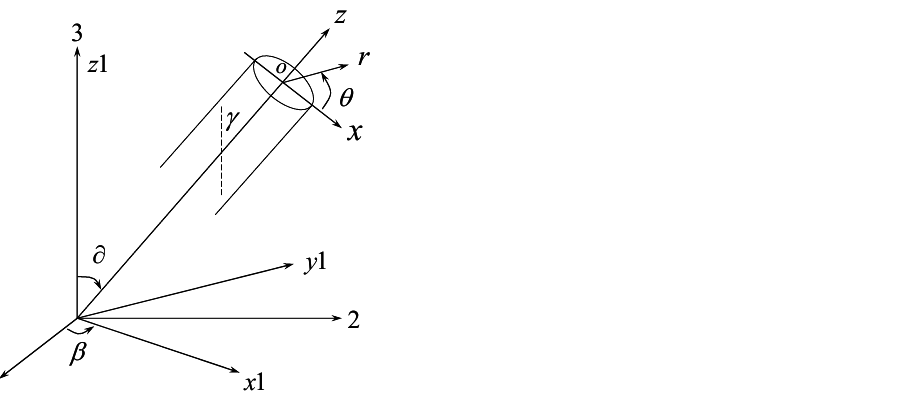
Figure 4. Coordinate system used to transform in situ ground stresses to that around the wellbore.